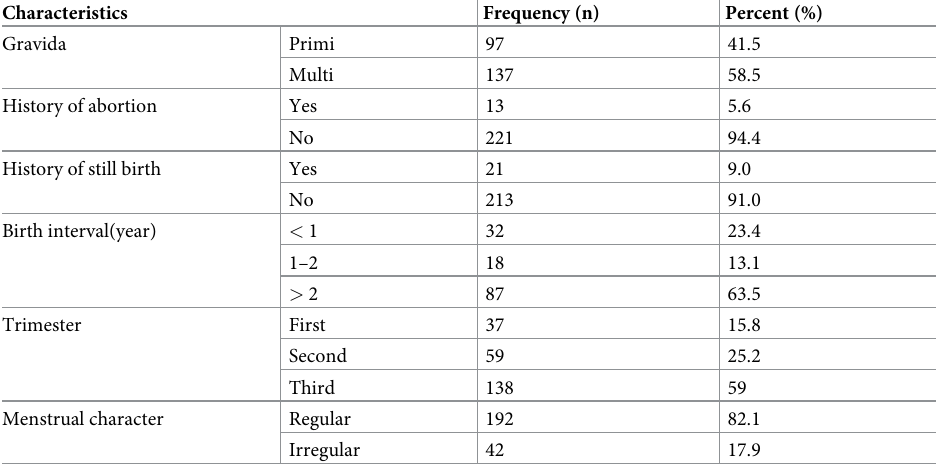
Table 3. Reproductive health factors among pregnant women attending antenatal care at Debre Markos Referral Hospital, Northwest Ethiopia, 2016.